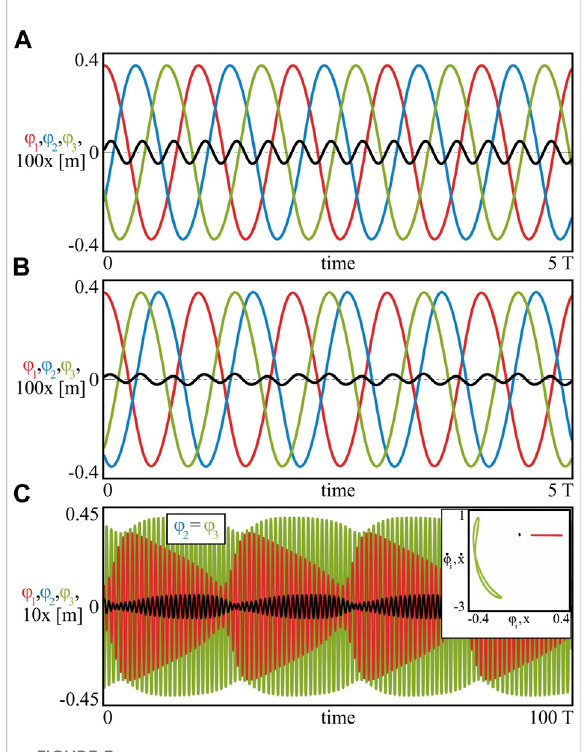
FIGURE 3 (Colour online). The periodic synchronous con fi gurations for the identical masses (A) m 1 = m 2 = m 3 = 1.0 [kg] and non – identical masses (B) m 1 = 1.0, m 2 = 0.7, m 3 = 0.5 [kg]. The scenario of quasiperiodic synchronization between the 2nd (blue) and the 3rd (green) node is shown in panel (C) for m 1 = 1.0, m 2 = 0.5, m 3 = 0.2 [kg]. In the case of three oscillators, both regular and irregular dynamics can arise, leading to more complex synchronous scenarios. System (1) with n = 3